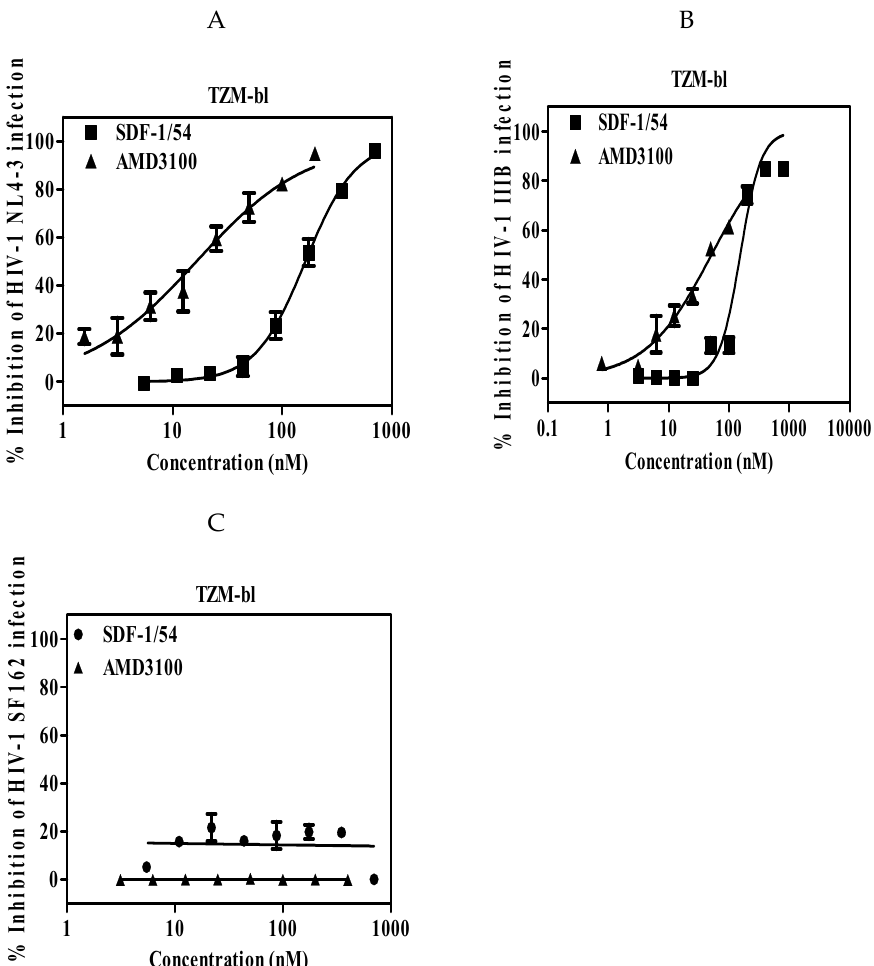
Figure 1. Antiviral potency of SDF-1/54 in a single-cycle viral infection. SDF-1/54-mediated inhibition of infection by infectious clone HIV-1 NL4-3 ( A ), laboratory-adapted HIV-1 IIIB ( B ) and HIV-1 SF162 ( C ) of TZM-bl cells. TZM-bl cells were pre-incubated with graded concentrations of SDF-1/54 for 15 min at 37 °C. Next, HIV-1 was added to the mixture. At 48 h post-infection, luciferase activity was detected. Average values (± SD) from three independent experiments are shown. Table 1. The inhibitory activities of SDF-1/54 on infection by two HIV-1 strains in TZM-bl cells